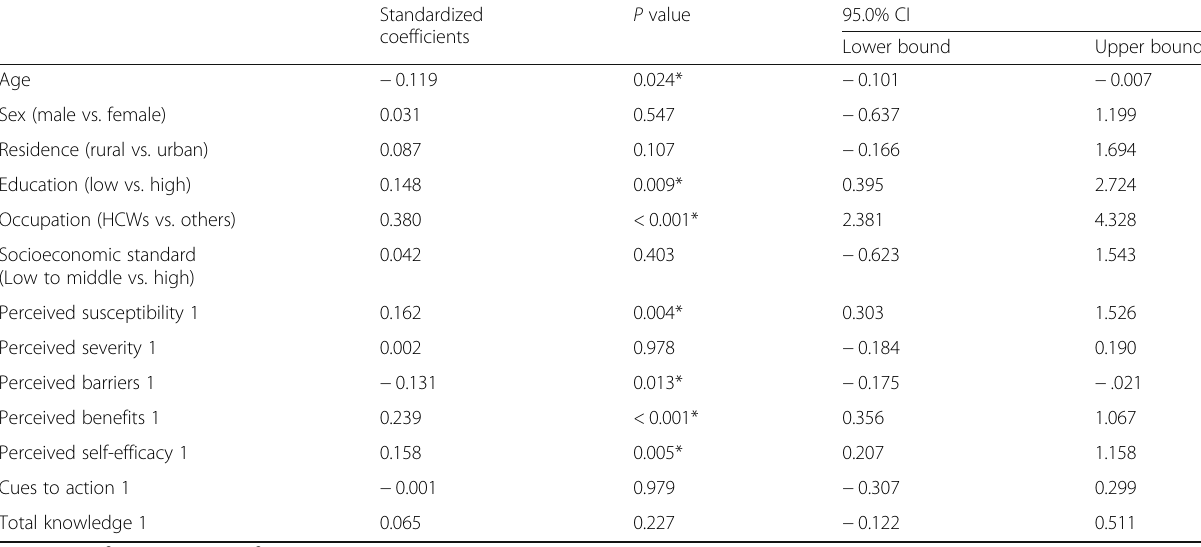
Table 4 Effects of health belief model constructs, total knowledge and demographic variables on COVID-19 preventive behaviours during the beginning of pandemic (first time of data